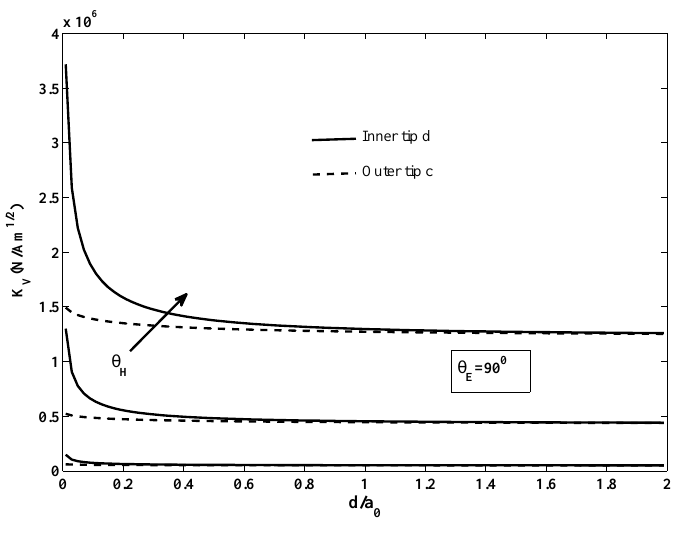
Fig. 19 MIIF versus inter-crack distance for different magnetic poling with fixed electric